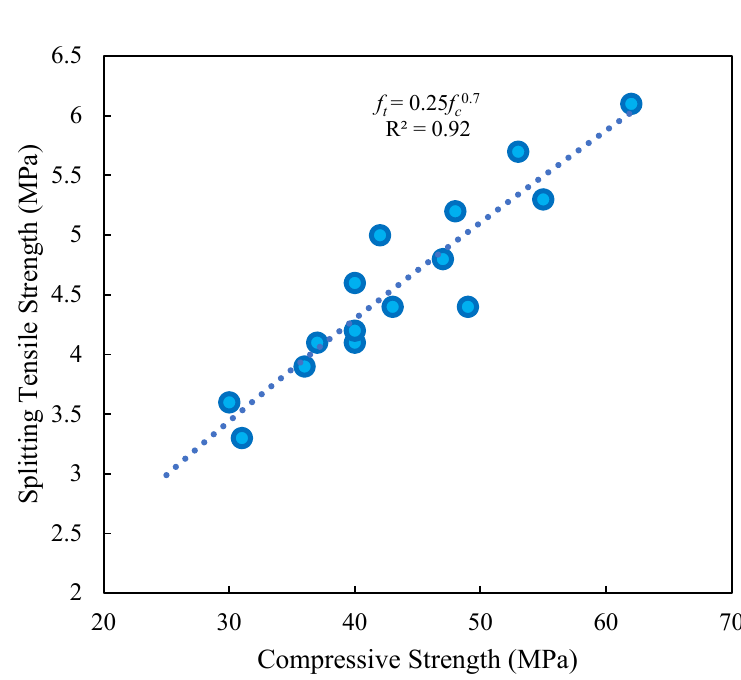
Figure 9. Relationship among compressive and tensile resistances of concrete containing different PF and RTA fractions.